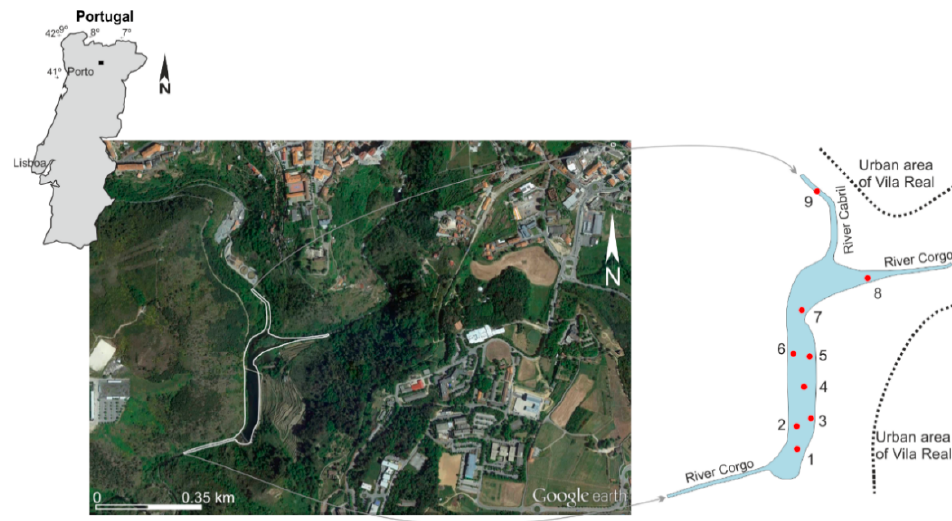
Figure 1. Image of the Terragido dam reservoir, in the River Corgo catchment, Northwest Portugal (latitude: 41°17’N; longitude: 7°44’W), and sampling sites ( ).